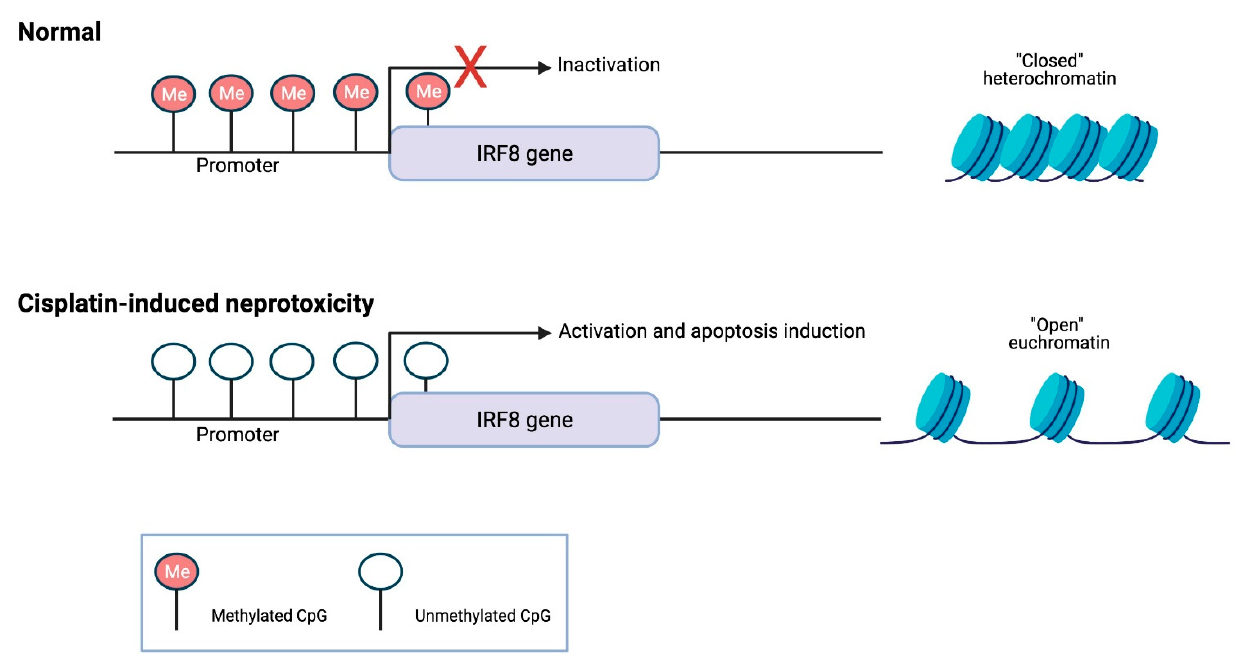
Figure 1. Demethylation of IRF8 gene promoter during cisplatin-induced nephrotoxicity, contributing to renal tubular cell apoptosis. Created with BioRender.com accessed on 21 May .